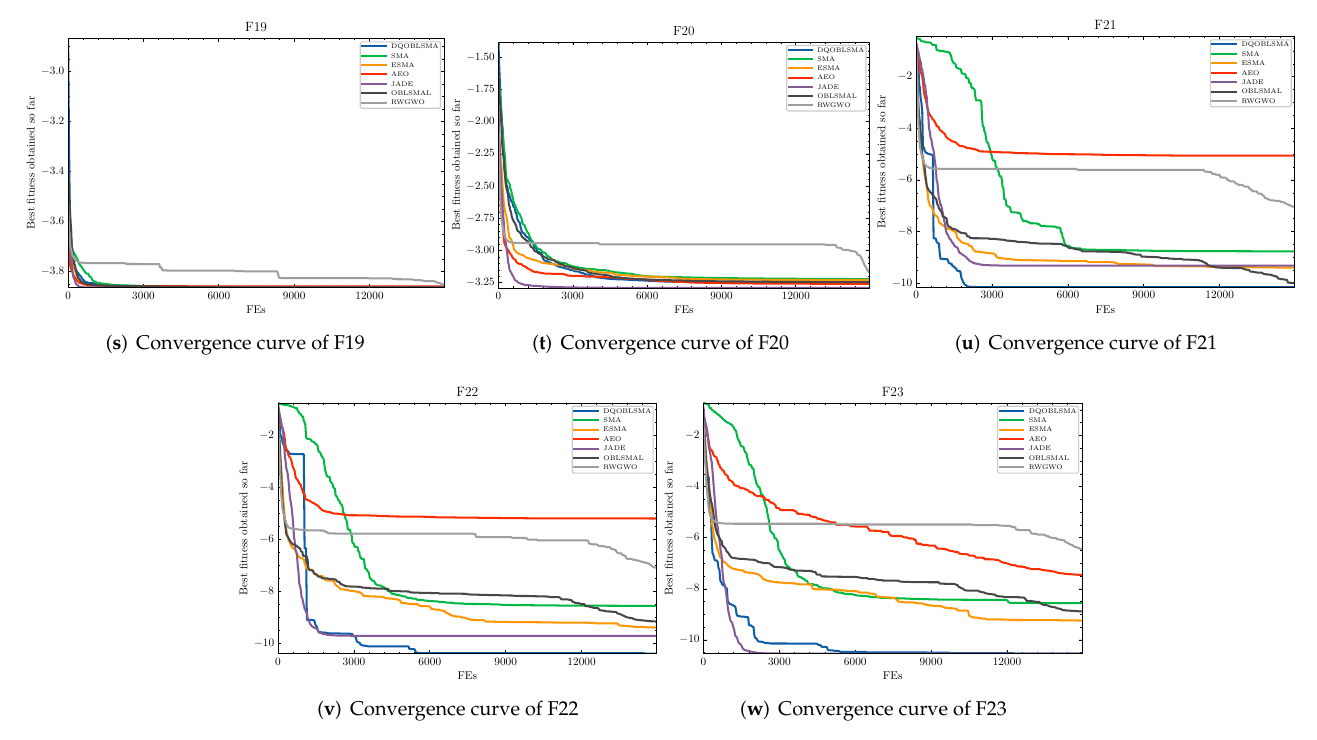
Figure 2. Convergence figures on test functions